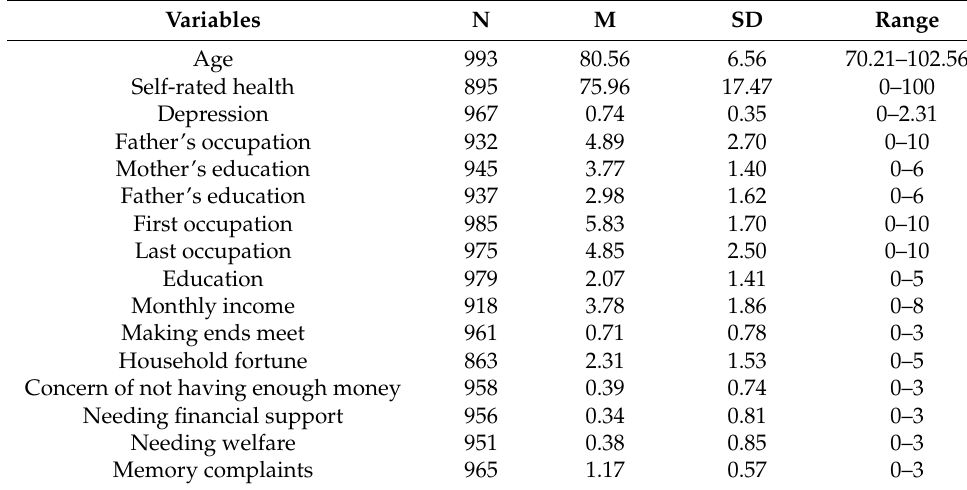
Table 2. Descriptive statistics of the observed variables entered in the